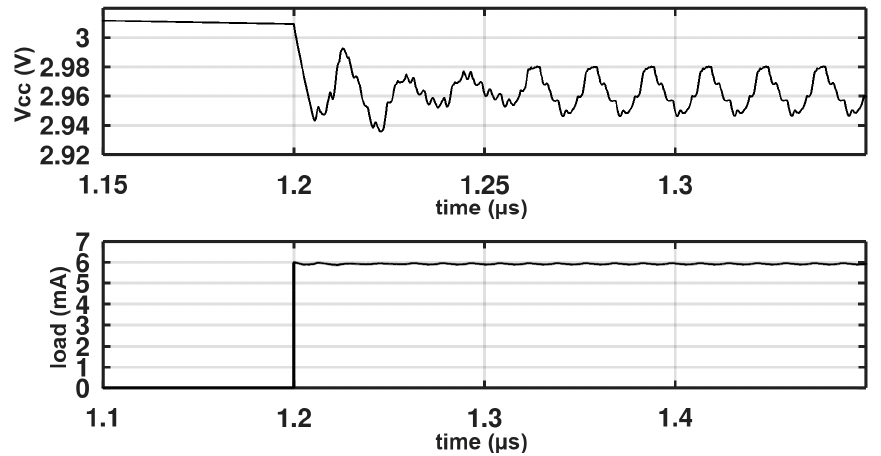
Figure 10. Transient response of the regulator when the load changes from 0 to 6 mA in 100 ps.